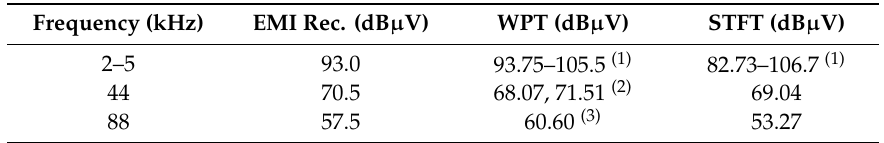
Table 1. Comparison of amplitudes of main spectrum components calculated with WPT and STFT and measured with EMI receiver (using the 1 kHz RBW results in Figure